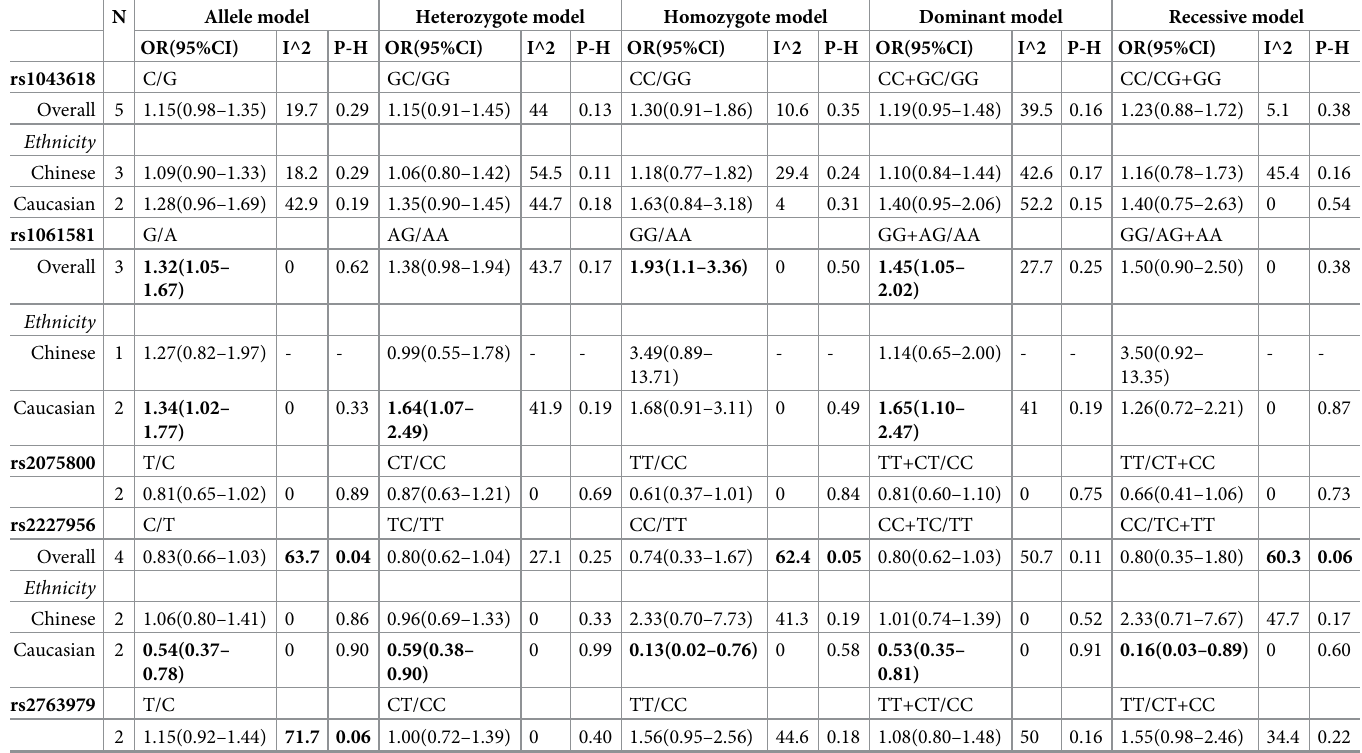
Table 2. Summary of pooled ORs in the